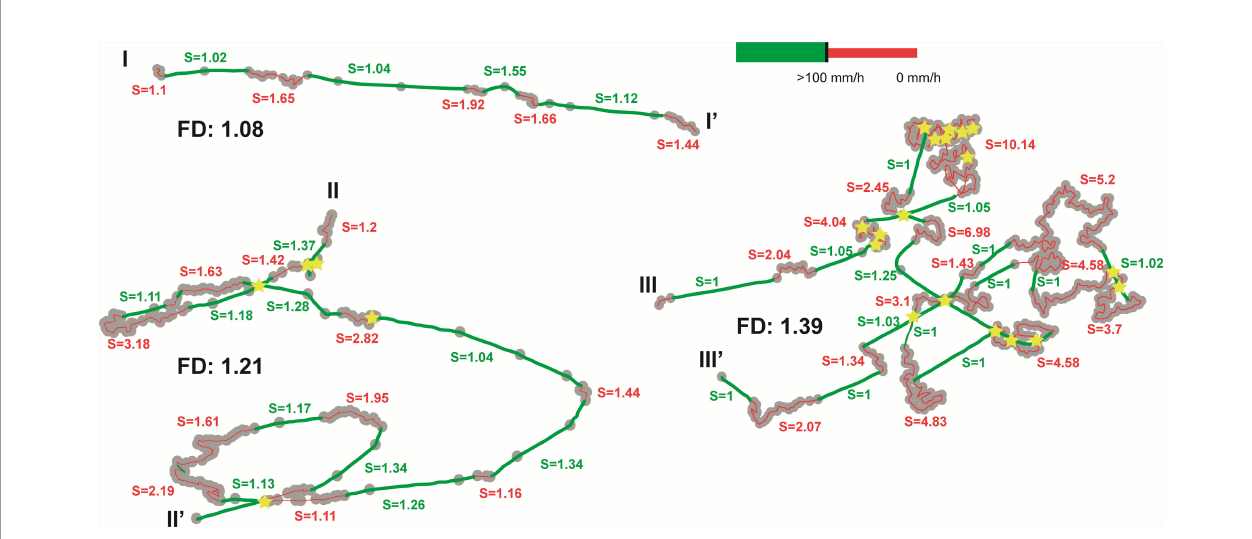
FIGURE 2 | Echinocrepis rostrata digitized trails (I-I ’ , II-II ’ , III-III ’ ) with their fractal dimension (FD) values. Red (thin) and green (thick) lines indicate low and high-speed periods respectively. Note that grey dots indicate the hourly position of the organism. Yellow stars indicate cross-cuts. S= tortuosity